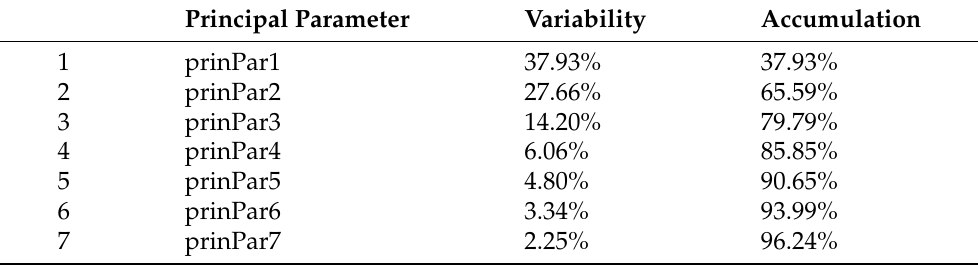
Table 4. Influence of the first seven principal parameters (prinPar) and the PCA model’s variability in comparison to the variability of the CAD